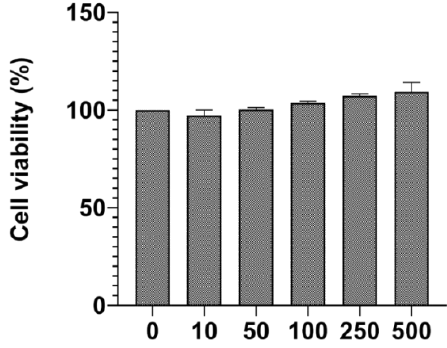
Figure 7. MTT assay results with L929 cells at different concentrations of alkali-treated nano HA, standard deviation measured using three independent values.